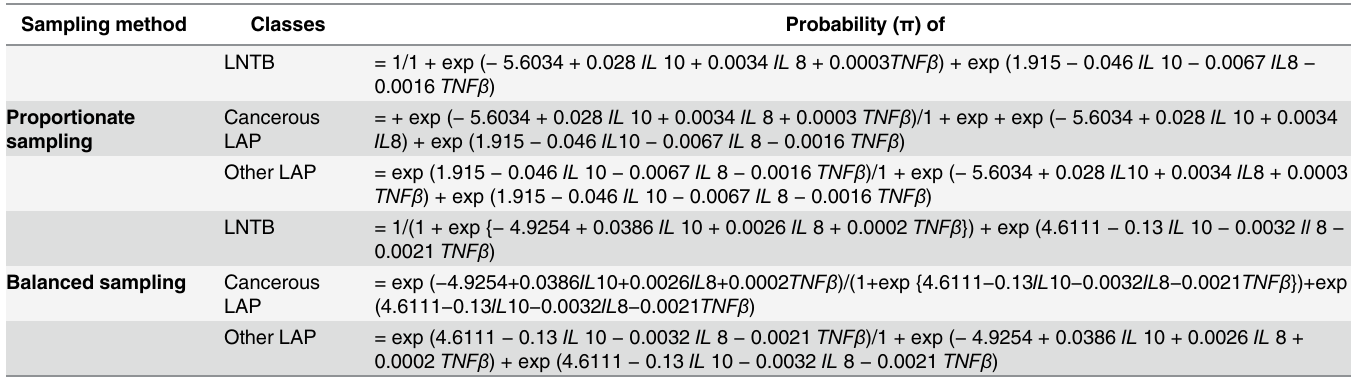
Table 4. Showing the equation for the prediction of probability ( π ) of the three lymphadenopathy classes using mean serum levels of IL-10, IL-8 and TNF- β . Sampling method